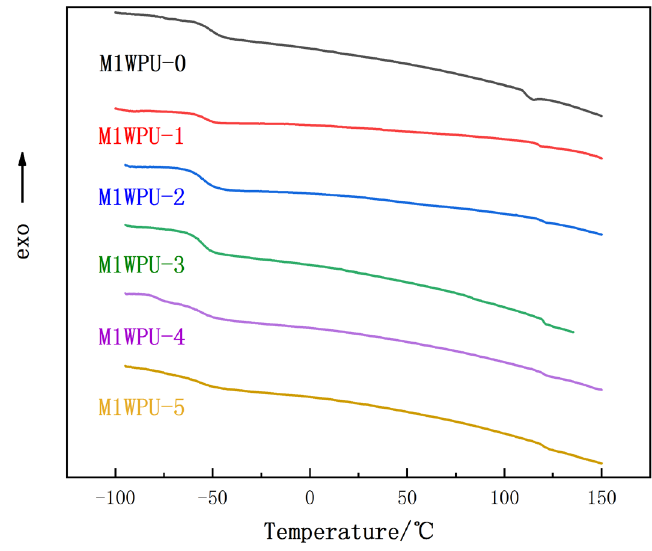
Figure 3. DSC result for M1WPU-0 to M1WPU-5. Table 4. Glass transition temperatures for M1WPU-1 to M1WPU-5. Sample